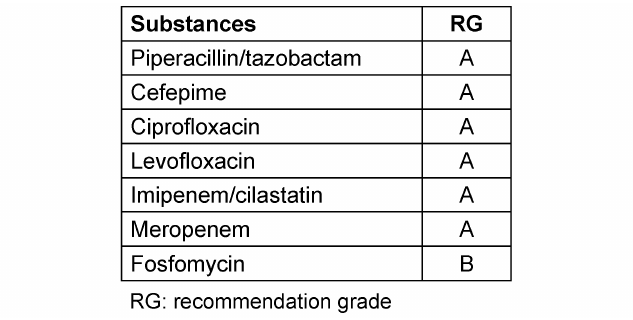
Table 3: Recommendation grade for the use of antibiotics in the